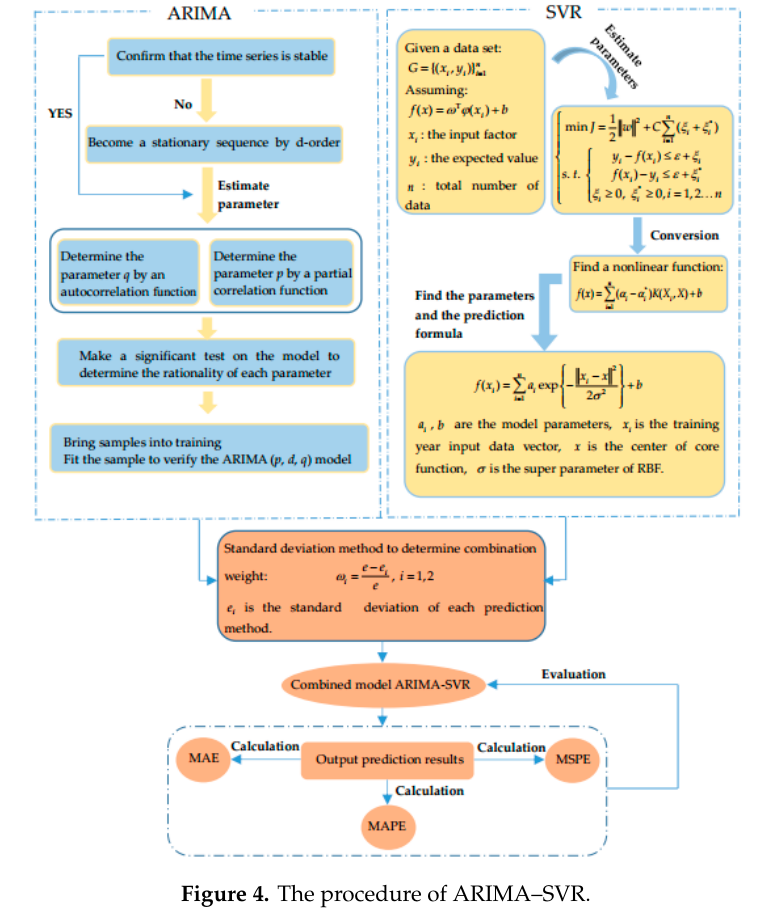
Figure 4. The procedure of ARIMA–SVR. Table 7. Parameter estimation of ARIMA.